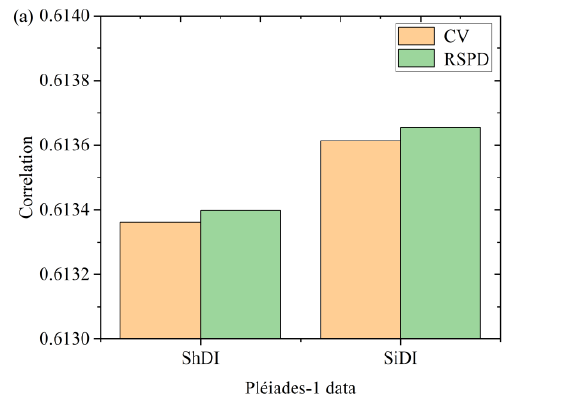
(b) Figure 7. Spatial distribution of ShDI and SiDI of Pléiades data in Case II region in 2018 (( a ) is ShDI, ( b ) is SiDI). Furtherly, we compared the correlation coefficient and ITD between the RSPD/CV based on Sentinel-2 data and ShDI/SiDI based on Pléiades-1 data. Since they have different